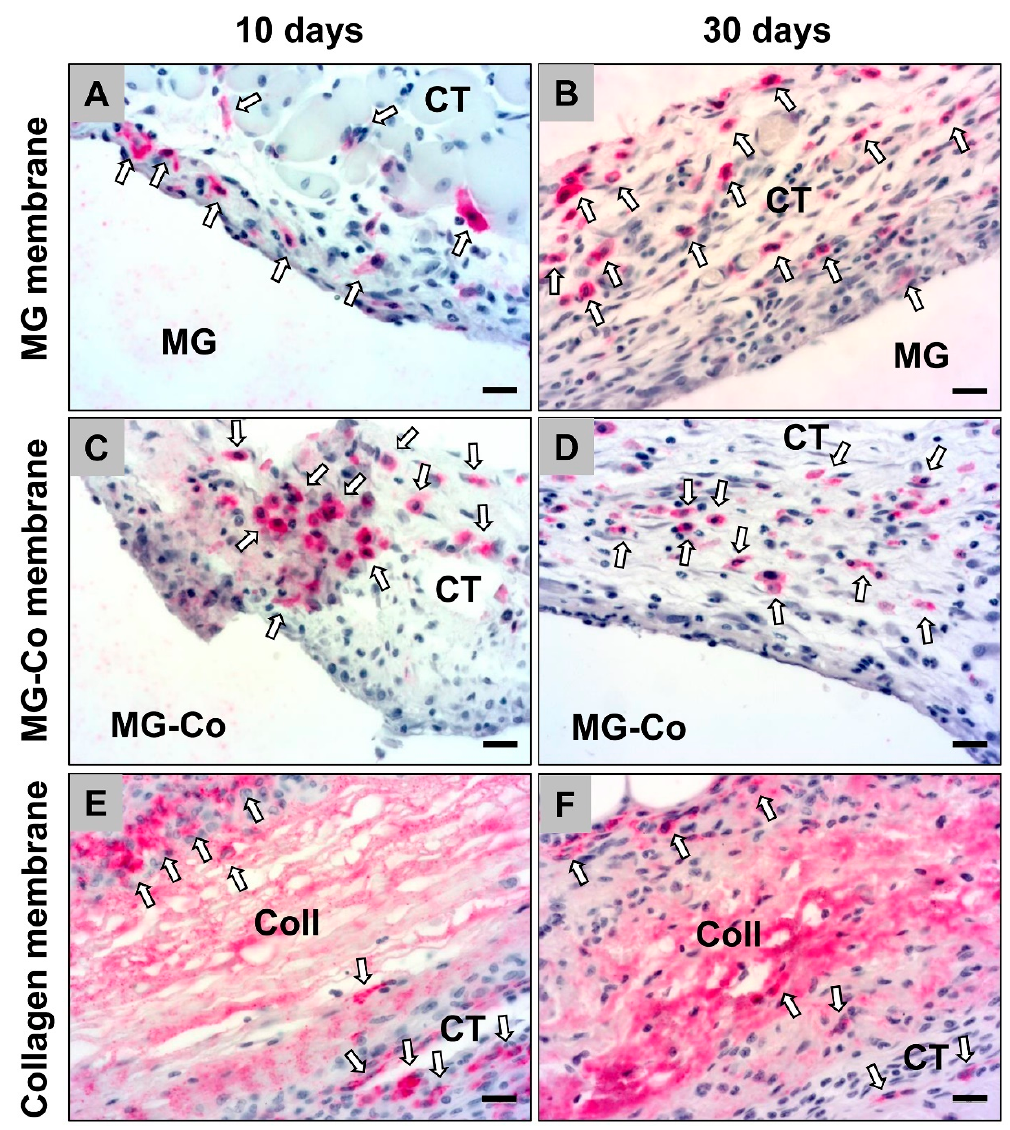
Figure 4. Exemplary histological images of anti-inflammatory (CD163-positive) macrophages (white arrows) within the implant beds of the different membranes, i.e., the pure magnesium membrane (MG) ( A , B ), the coated magnesium membrane (MG-Co) ( C , D ) and the collagen membrane (Coll) ( E , F ). CT = connective tissue (CD163 immunostainings, 400× magnification, scale bars = 10 μ m).